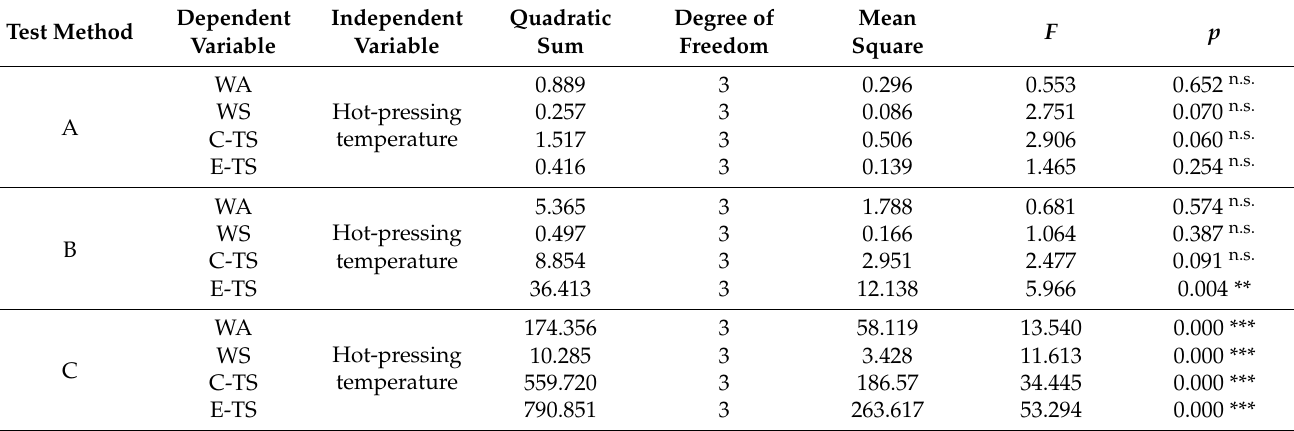
Figure 2. Water resistance of bamboo scrimber samples with di ff erent hot-pressing temperatures during three tests: ( a ) water absorption rate (WA), ( b ) width swelling rate (WS), ( c ) thickness swelling of the center point (C-TS), and ( d ) thickness swelling of the edge point (E-TS). Table 2. Analysis of variance (ANOVA) of the hot-pressing temperature on the water resistance of bamboo